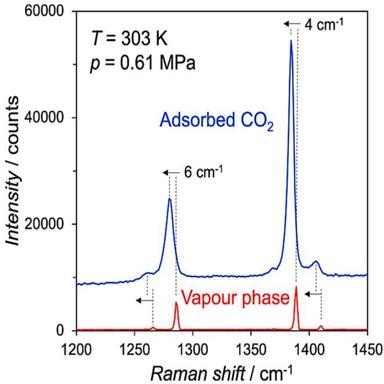
Comparison of Raman spectra for carbon dioxide within a silica-gel particle (adsorbed CO2) and in the vapor phase surrounding the particle. Adsorption results in a broadening and red-shift to lower wavenumbers of the Fermi-dyad peaks. Both spectra were measured at the same experimental conditions (the elevated background is due to the silica gel).